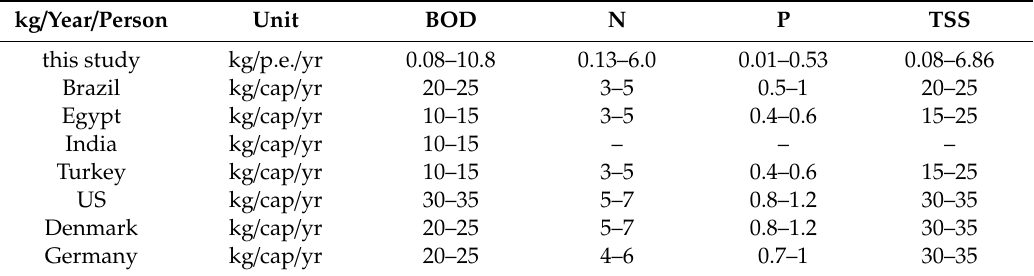
Table 3. Comparison between the person load in Bulgaria and other countries.